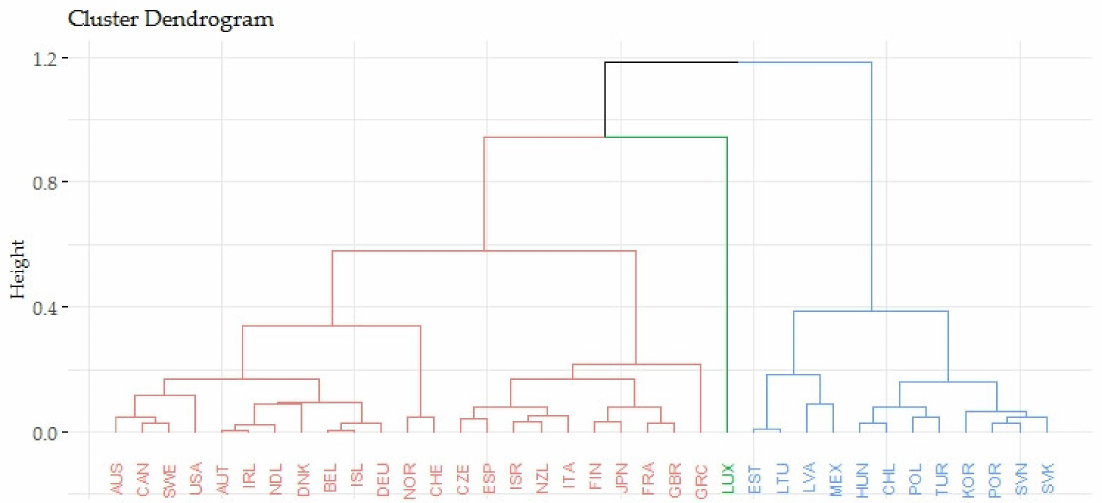
Figure 3. Hierarchical clusters of OECD countries—the relations of economic prosperity and gender inequalities in causes of